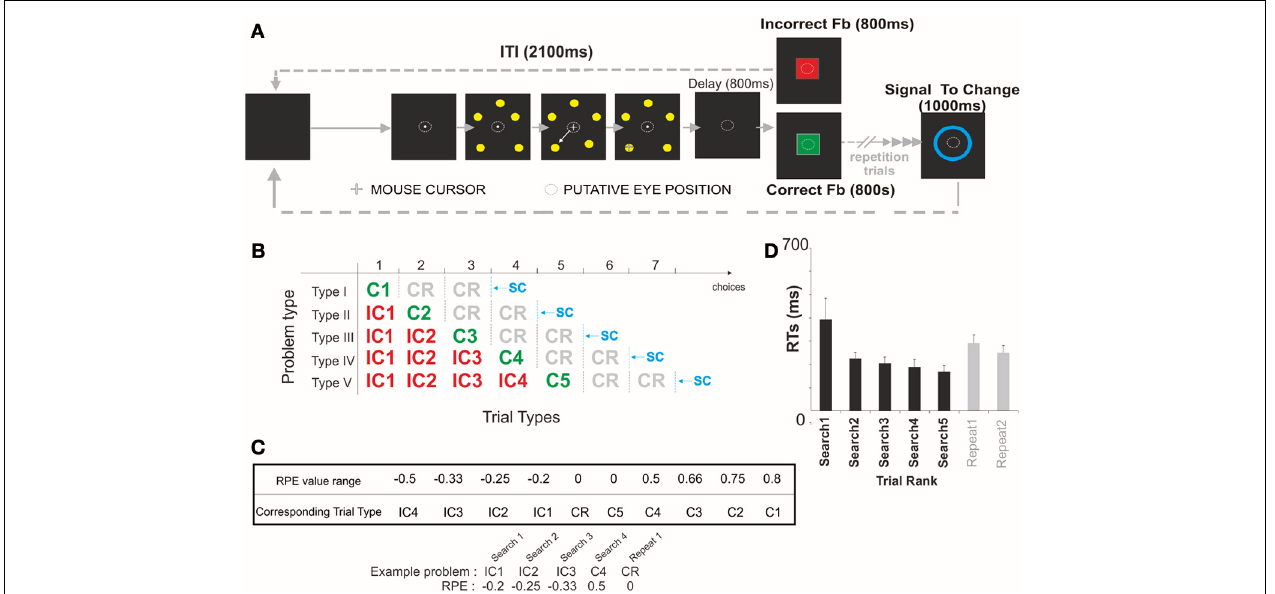
FIGURE 1 | Behavioral task and performance. (A) Schematic representation of the Problem Solving Task. The goal of the subject was to find by trial and error which one of 5 stimuli was associated with positive feedback. Each trial started with the target presentation. During this period subjects had to chose one stimulus using four computer mouse buttons. Once a target was selected using a computer mouse, the 5 stimuli were switched off. A 800ms delay followed and preceded the appearance of the feedback. The feedback (a positive feedback was a green square; a negative feedback was a red square) was displayed on the screen during 800ms and its offset was followed by a 2100ms inter-trial interval (ITI). After an incorrect choice, subjects continued to search for the correct stimulus while keeping in memory the previous erroneous choices. Discovering the correct stimulus (i.e., associated with green square feedback) ended the search period. The subjects then repeated the correct choice (i.e., repetition period, see shaded area). Immediately after the discovery of the correct target, or after one or two repetition trials, a blue ellipse appeared on the center of the screen 800ms after the offset of the correct feedback. This ellipse presented for 1000ms indicated that a new problem would start. (B) Problem types and trials. The problems the subjects were